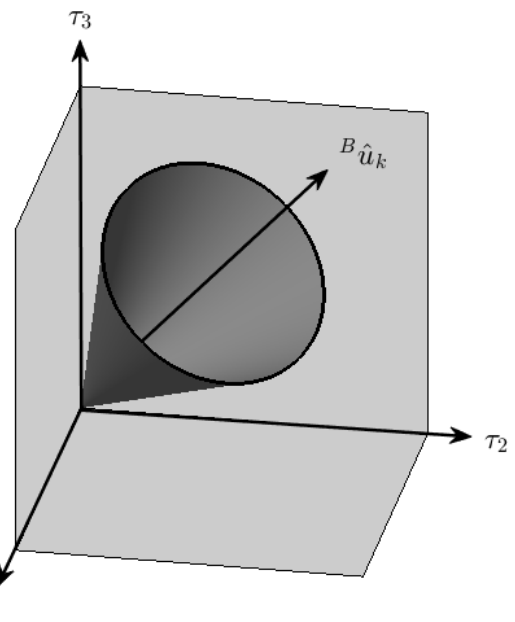
Figure 6. Case 2: the delta-v cone does not intersect with any plane and does not include any